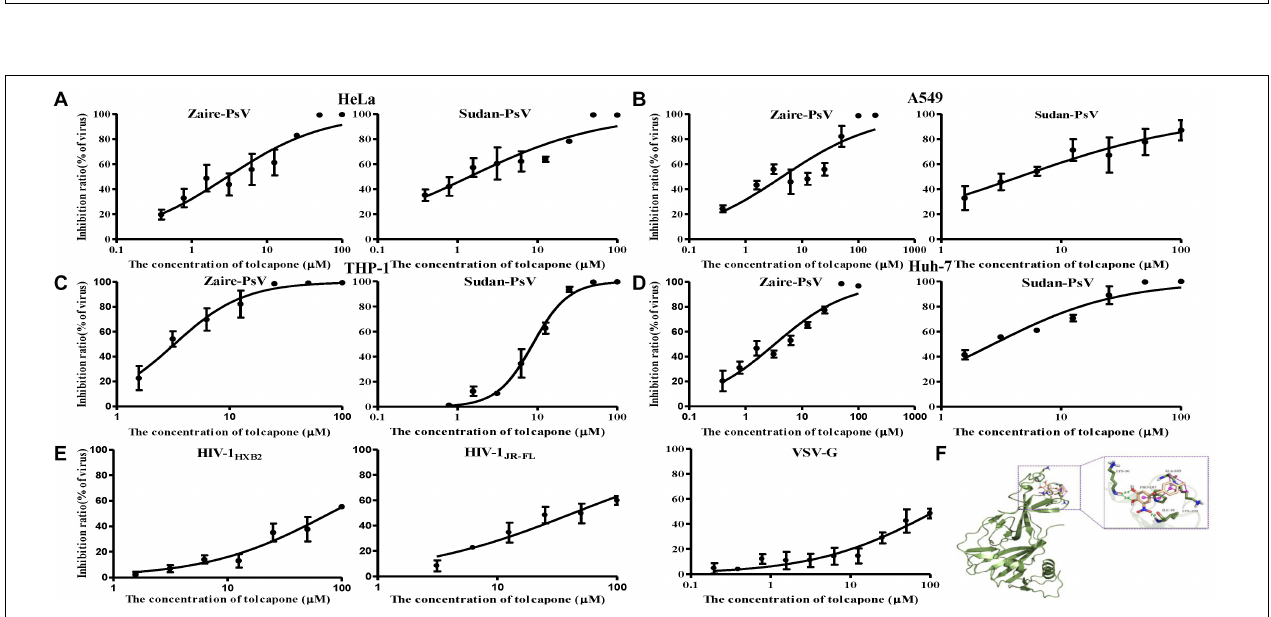
FIGURE 7 | Tolcapone was a potent entry inhibitor of both Zaire PsV and Sudan PsV. The indicated concentrations of tolcapone were incubated with Zaire-PsV (left panel) or Sudan-PsV (right panel), respectively, for 30 min at room temperature. The mixtures were then added to prepared (A) HeLa, (B) A549, (C) THP-1, and (D) Huh-7 cells. Luciferase activities were measured at 72 h post-infection. Each sample was tested in triplicate, and the data are presented as the mean ± SD. (E) % Inhibition of HIV-1HXB2 (left panel), HIV-1JR-FL (middle panel), and VSV-G (right panel) infection by tolcapone. (F) Presumed binding sites of tolcapone to Ebola glycoprotein. According to the computational docking results, tolcapone formed hydrogen bonds with LYS56 and ILE38, and it bound to LYS190, ALA189, and PRO187 by hydrophobic interactions.